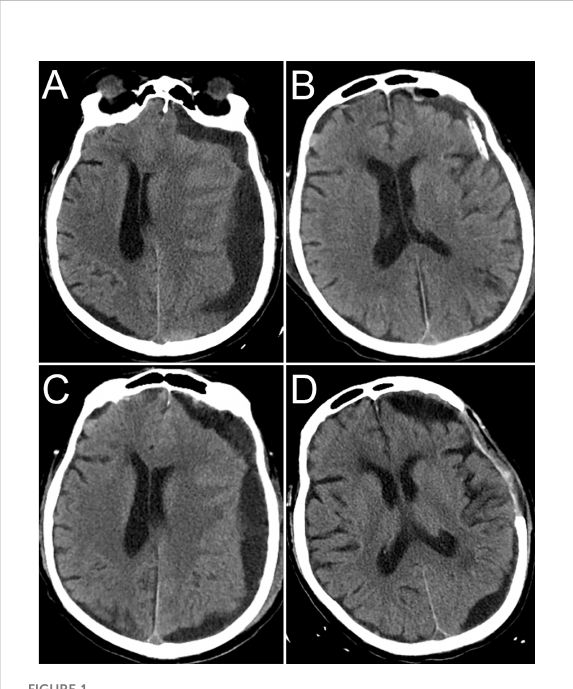
FIGURE 1 CT images during hospitalization. CT before the fi rst surgery (A) , CT after the fi rst surgery (B) , CT before the second surgery (C) , CT 1 month after the second surgery (D)